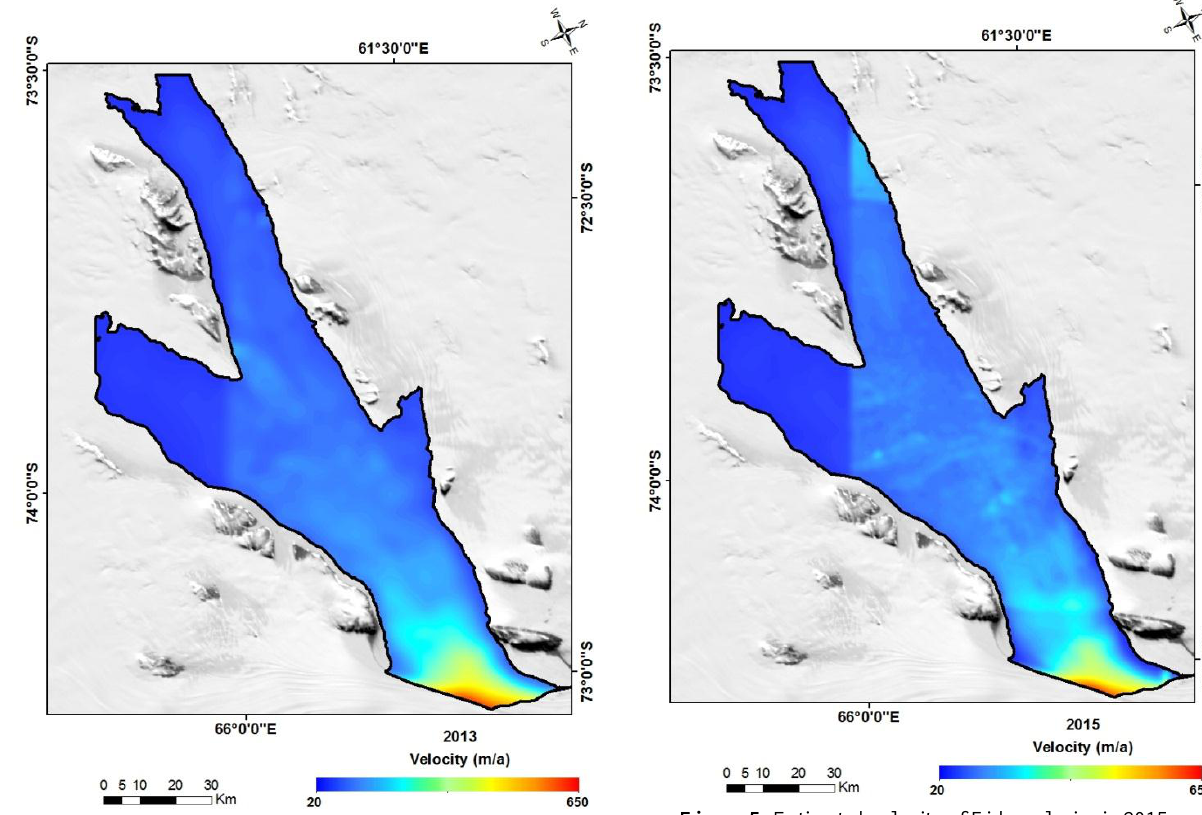
Figure 3: Estimated velocity of Fisher glacier in 2013.